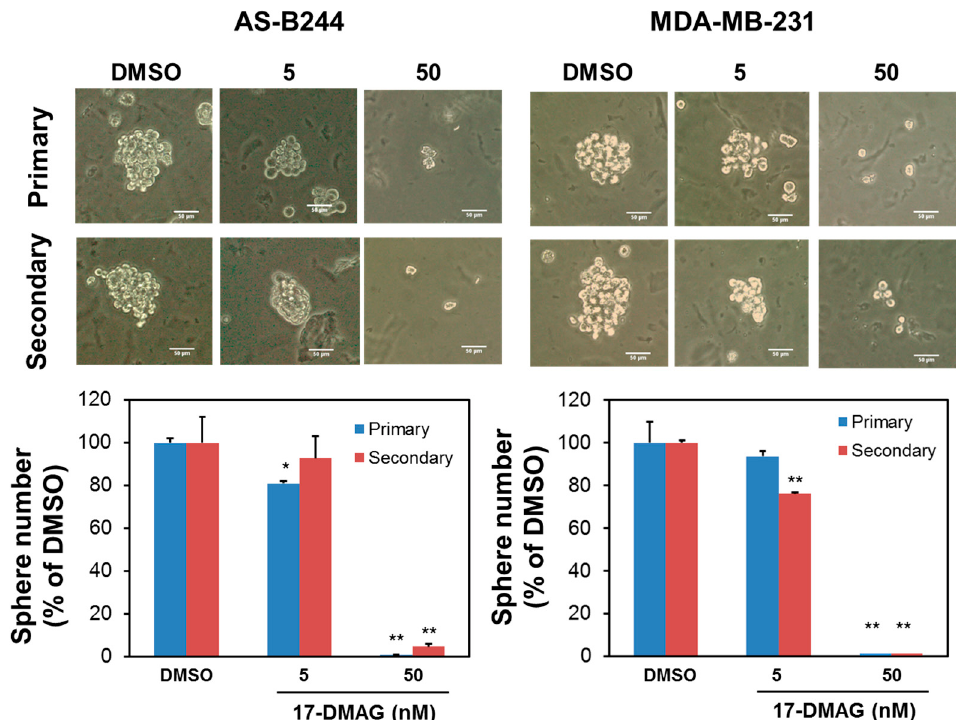
Figure 1. 17-DMAG inhibited proliferation of mammospheres derived from Triple-negative breast cancer cells (TNBC). AS-B244 or MDA-MB-231 TNBC cells were cultured under mammosphere cultivation conditions and treated with 0.1% dimethyl sulfoxide (DMSO) or the indicated concentration of 17-DMAG. The number of primary mammospheres was counted at Day 7 and mammospheres were then collected, dissociated into single cells, and subjected to secondary mammosphere formation. Data were presented as the percentage of DMSO control. * p < 0.05; ** p < 0.01.